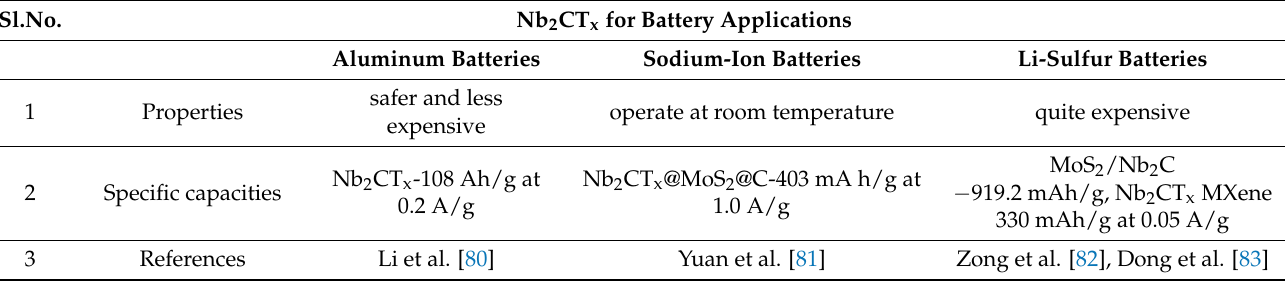
Table 2. Summary of the Nb 2 CT x and based materials for battery applications.